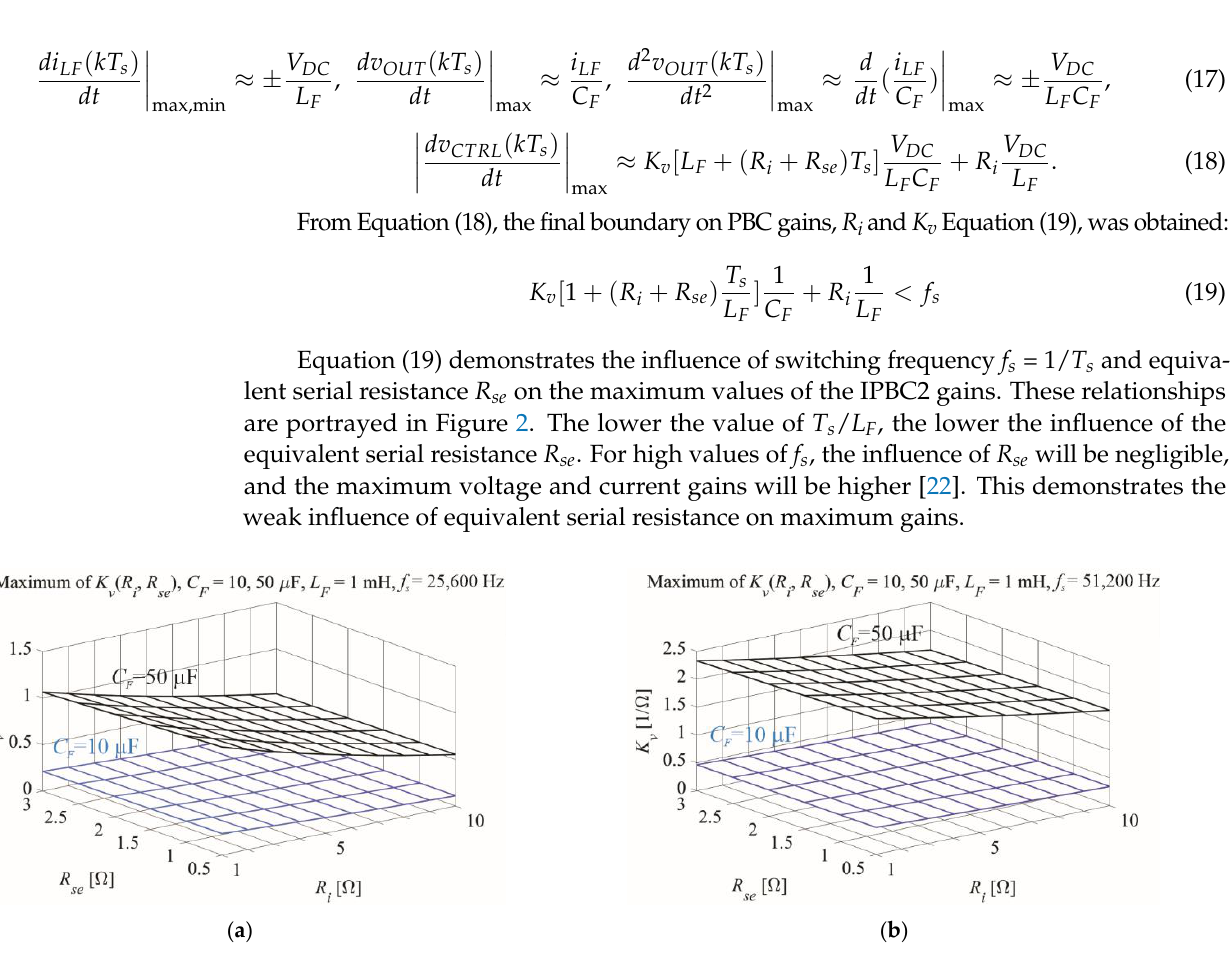
Figure 2. The dependence of maximum voltage gain K v on current gain R i and equivalent serial re- sistance R se for ( a ) f s = 25,600 Hz and ( b ) f s = 51,200 Hz. In practical terms, the gains do not depend on R se for the assigned VSI parameters, L F = 1 mH and C F = 50 μF.